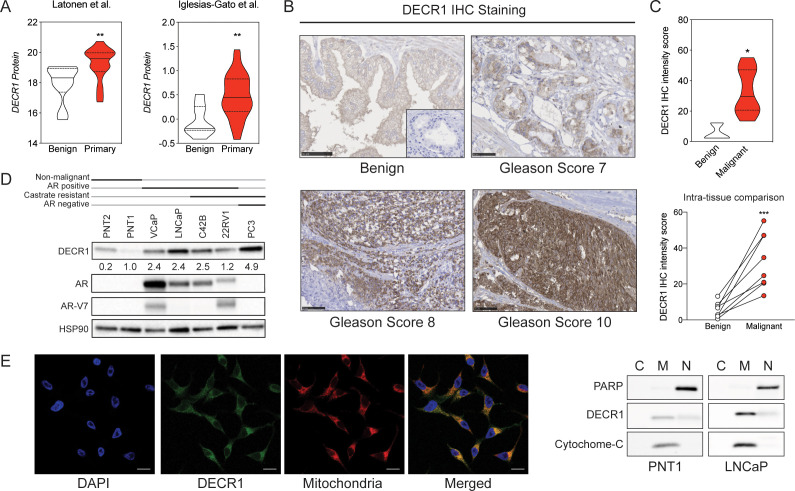
DECR1 protein in overexpressed in malignant prostate cells/tissues.(A) Violin plots of DECR1 protein overexpression in primary PCa tissues compared to benign prostate tissues in two independent datasets. (B) Representative DECR1 IHC staining of benign prostate tissues and PCa tissues (negative control stain included in bottom right box). Scale bar, 50 µm. (C) Violin plot of DECR1 protein expression in a validation cohort consisting of benign prostate tissues (n = 3) and PCa tissues (n = 8) (top panel). Intra-tissue IHC analysis of DECR1 expression in PCa tissues (n = 8) (bottom panel). (D) DECR1 protein expression in non-malignant prostate cell lines (PNT1 and PNT2) and PCa cell lines (LNCaP, VCaP, 22RV1, C42B and PC3). (E) Immunocytochemistry staining of LNCaP cells to determine the subcellular localization of DECR1: nuclei were labelled using DAPI; mitochondria were labelled using MitoTracker Red; and DECR1 proteins were labelled using Alexa Fluor 488 secondary antibody, (Scale bar = 10 μm). Immunoblot of PNT1 and LNCaP cells separated into cytosolic, mitochondrial and nuclear fractions and incubated with poly (ADP-ribose) polymerase (PARP) and cytochrome-C antibodies to mark nuclear and mitochondrial fractions. Data are represented as violin plots in GraphPad prism: the horizontal line within the violin represents the median. Statistical analysis was performed using a Mann-Whitney two-tailed t-test (A and C top panel), or two-tailed paired t-test (C bottom panel): *p<0.05, **p<0.01 and ***p<0.001.